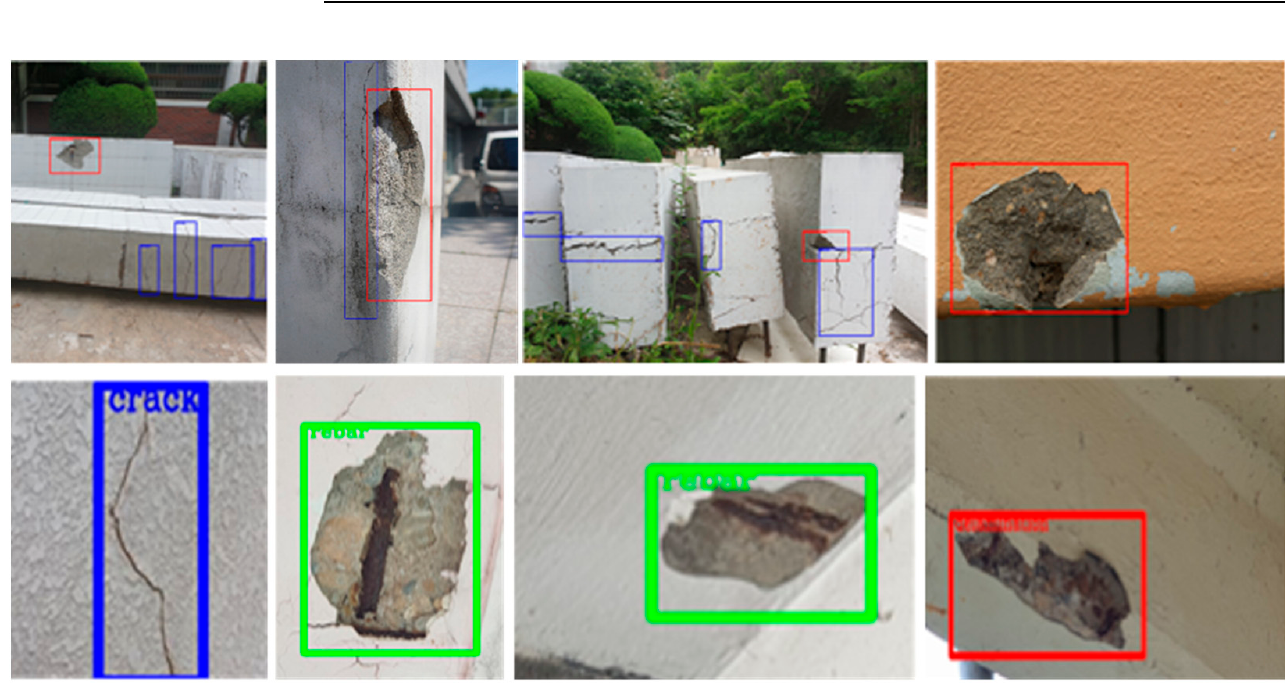
Figure 8. Damage detection using the Faster RCNN. Table 1. Performance evaluation of the concrete damage detection model.